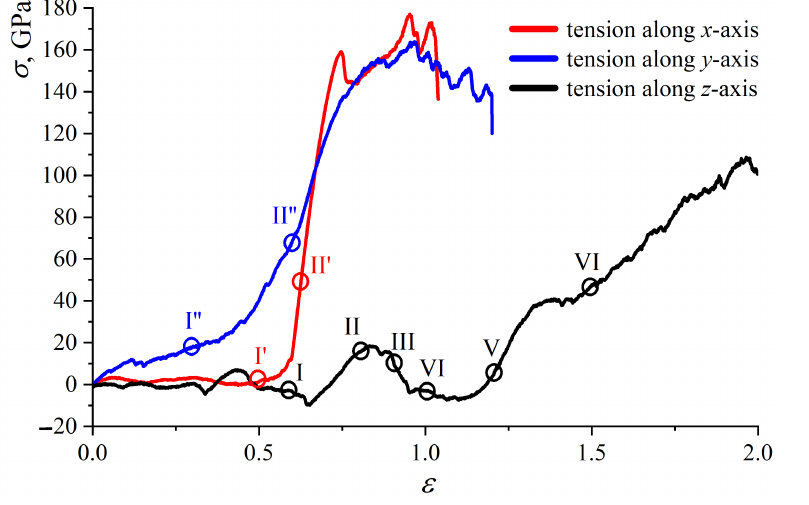
Figure 3. Stress–strain curves during uniaxial tension for MG. Lables I–VI, I’, I”, II’, II” show some critical points for further structural